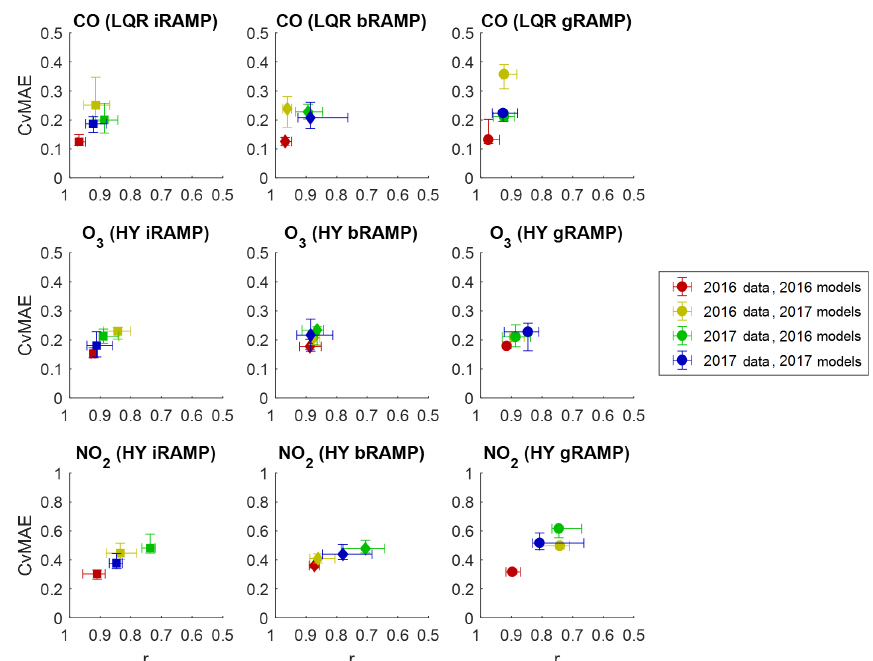
Figure 6. Comparative performance of models in 2016 and 2017. The “models” year indicates the year from which training data collected at the CMU site are used to calibrate the model; the “data” year indicates the year from which testing data collected at the CMU site are used to evaluate the